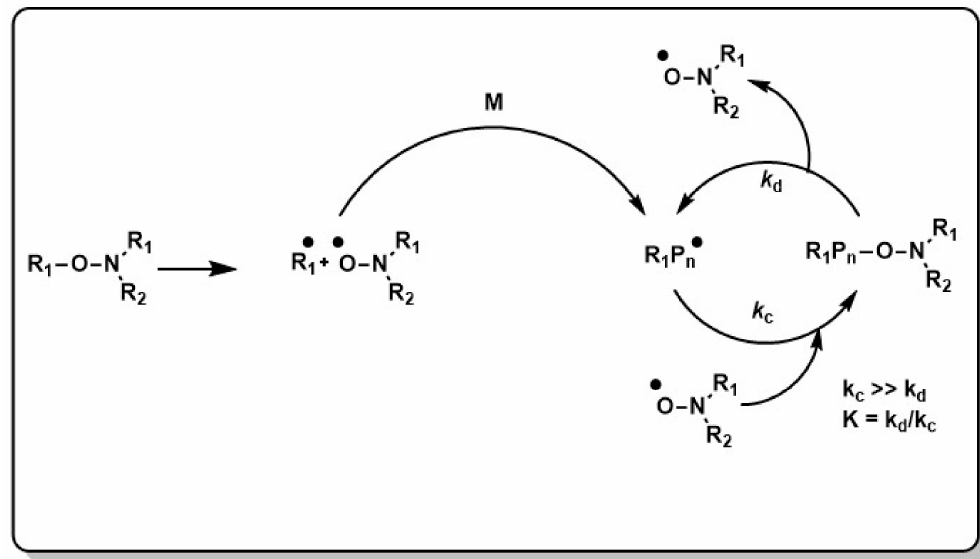
Scheme 2. General scheme of the reaction mechanism in